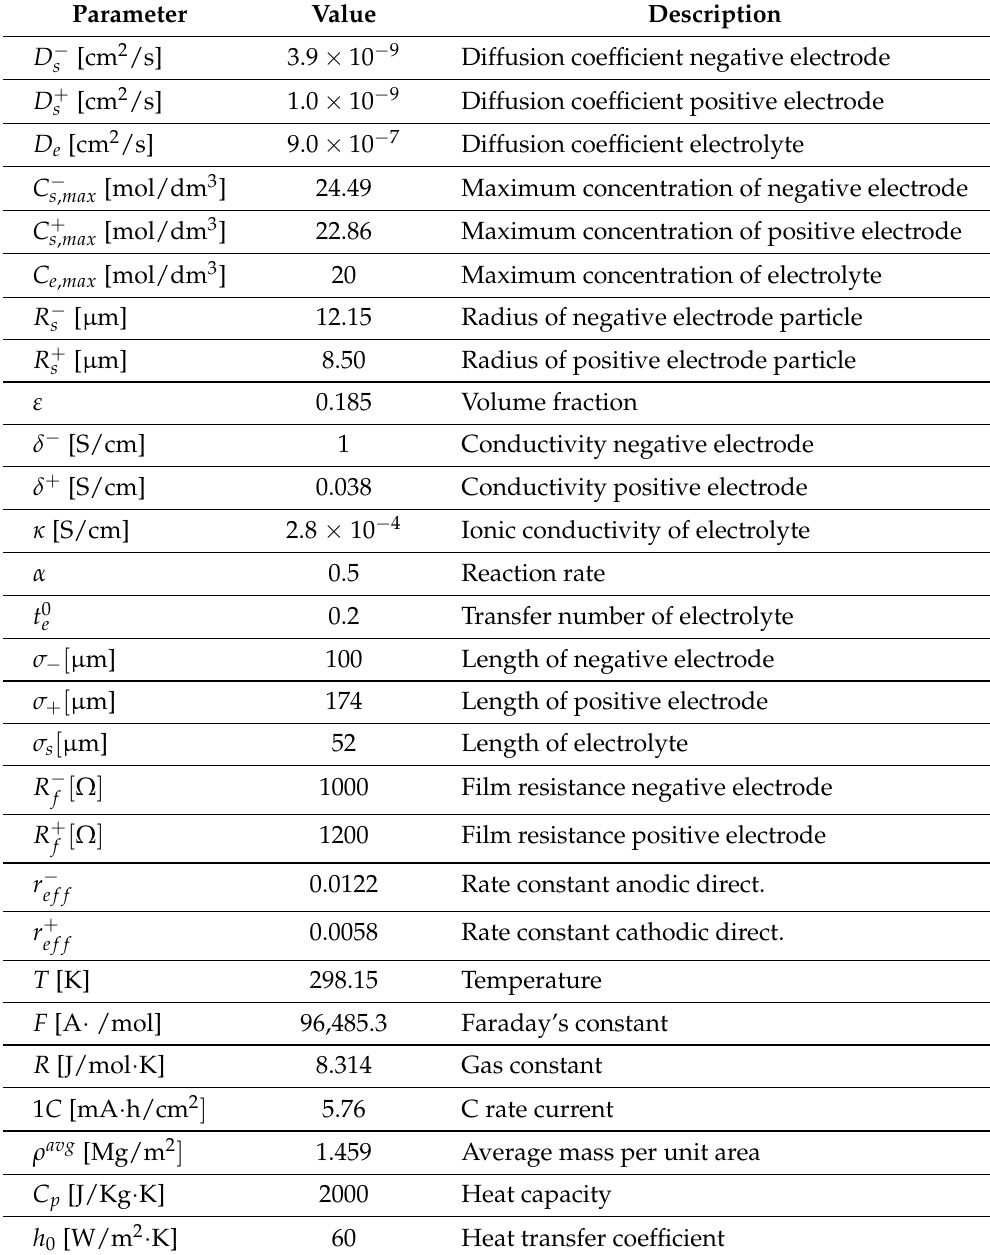
Table A1. Model parameters used in the simulation